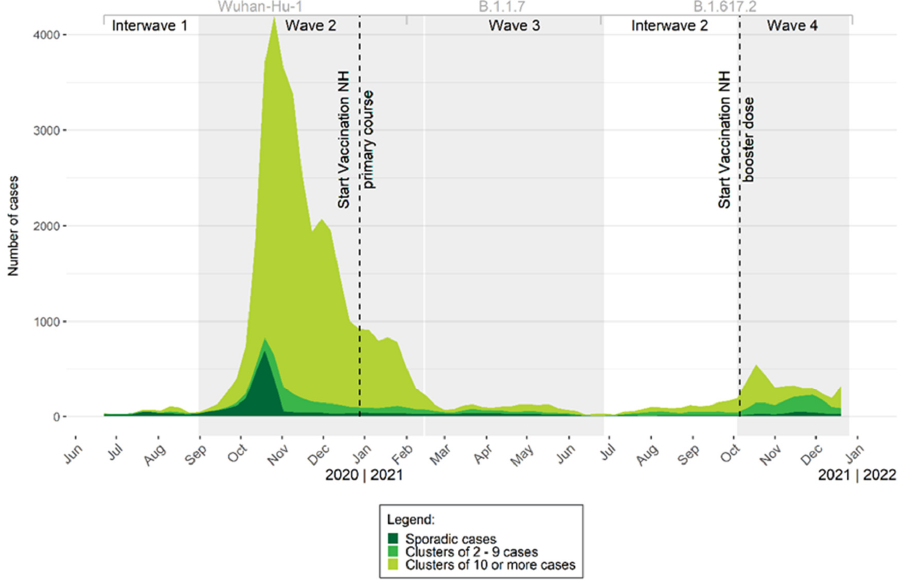
Figure 2. Evolution of the number of confirmed COVID ‐ 19 cases among nursing home (NH) resi ‐ dents by week in Belgium, from 22 June 2020 to 2 January 2022. Grey boxes indicate the second, third and fourth COVID ‐ 19 wave (from left to right). Dotted lines indicate the starts of the primary course vaccination campaign and of the booster vaccination. Wuhan ‐ Hu ‐ 1: Severe acute respiratory syndrome coronavirus 2 (wild type); B.1.1.7: Alpha variant; B.1.617.2: Delta variant; NH: nursing